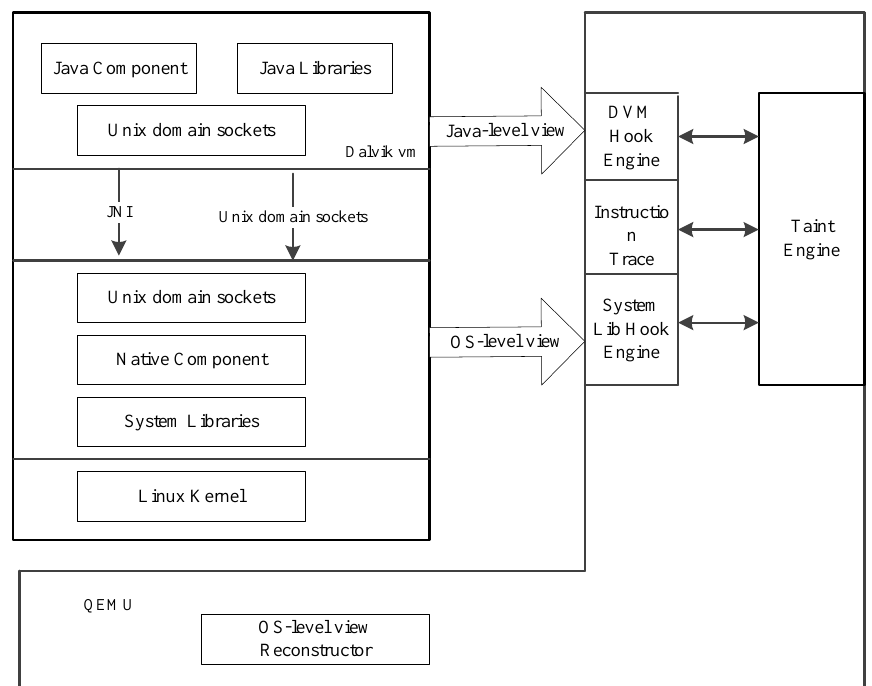
Figure 4. JDroid overview.